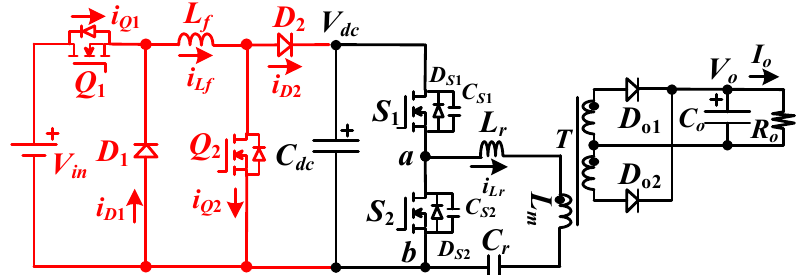
Figure 1. The circuit diagram of the presented converter with 16:1 ( V in,max = 16 V in,min ) voltage range operation.